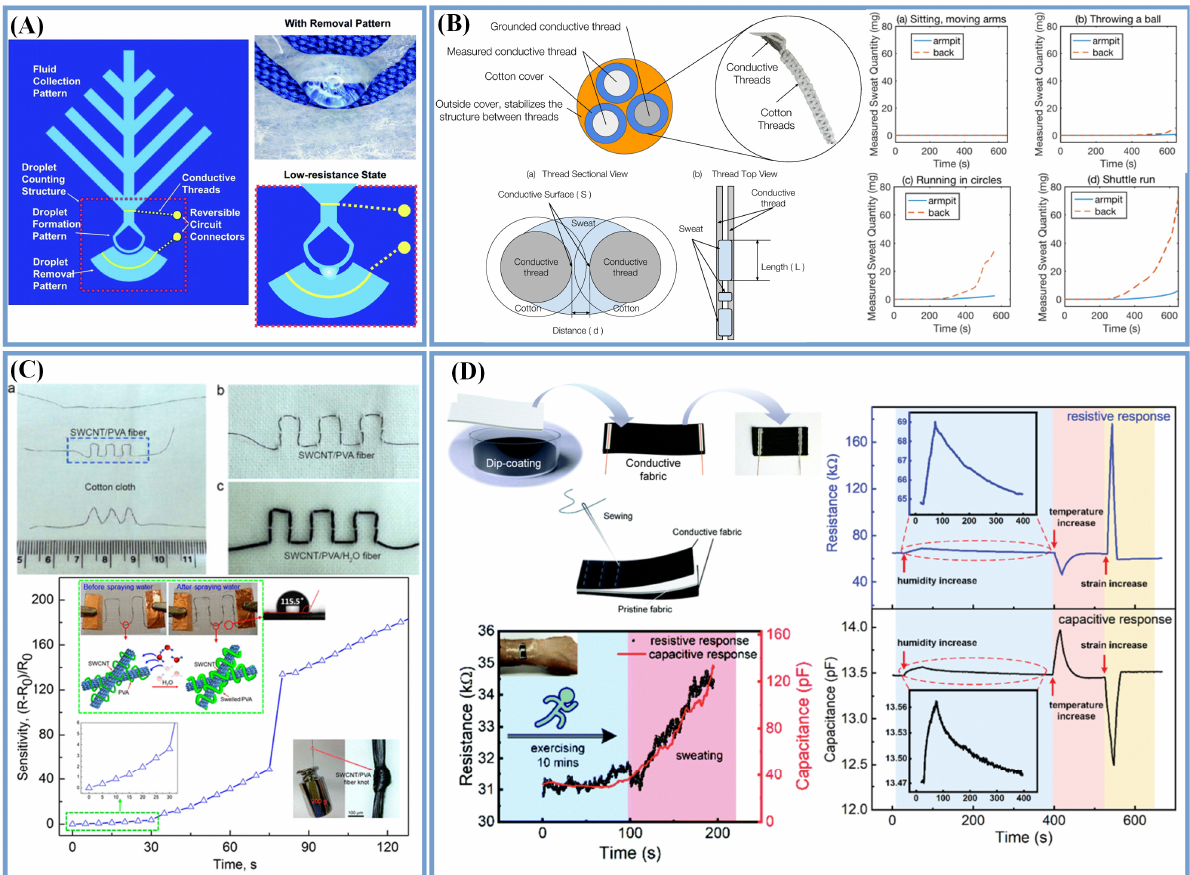
Figure 4. Various sweat-quantity-measuring and sensing devices. ( A ) The sweat forms a con- nected/low resistance state between the two fabrics (Adapted with permission from Ref. [98]. Copy- right 2017, copyright Royal Society of Chemistry); ( B ) The conductivity between the three conductive threads varies according to the amount of sweat absorbed [19]; ( C ) Resistance changes by expanding PVA molecular chains by absorbing water molecules (Adapted with permission from Ref. [40]. Copy- right 2017, copyright American Chemical Society); ( D ) Humidity sensors integrated with resistance and capacitance (Adapted with permission from Ref. [51]. Copyright 2021, copyright Royal Society of